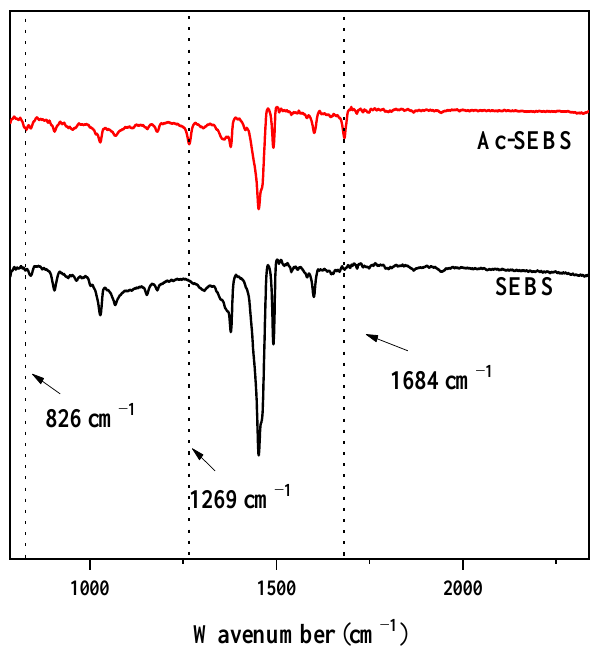
Figure 2. IR spectra of SEBS and Ac-SEBS.